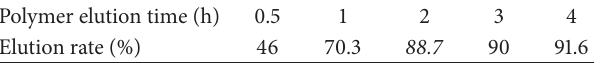
Table 2: Time effect on elution rate of TBT with